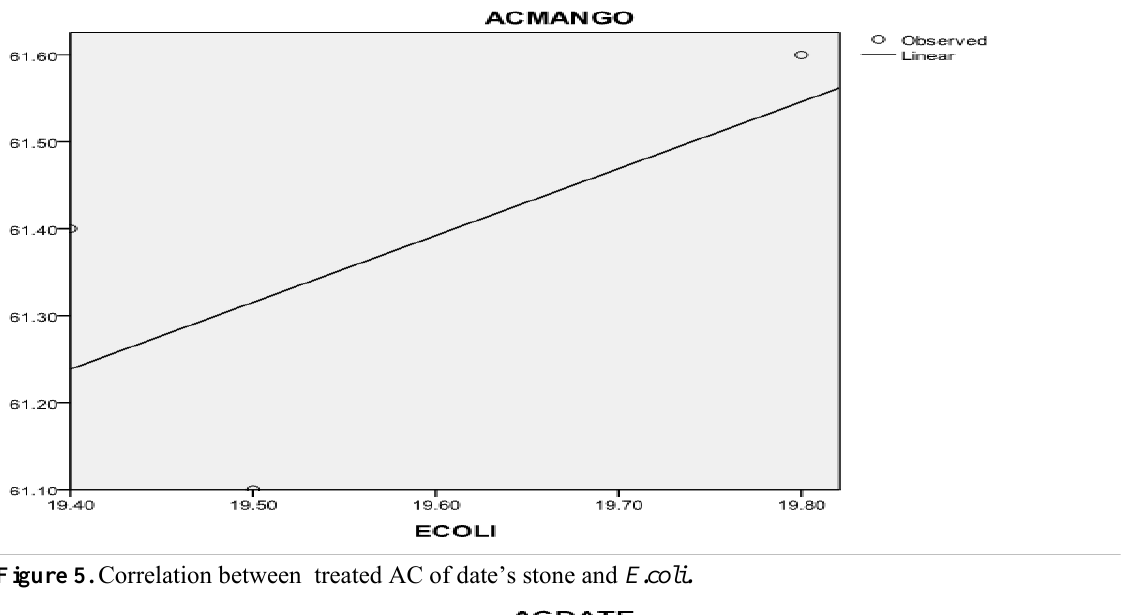
Figure 4. Correlation between treated AC from mango seeds and E.coli.